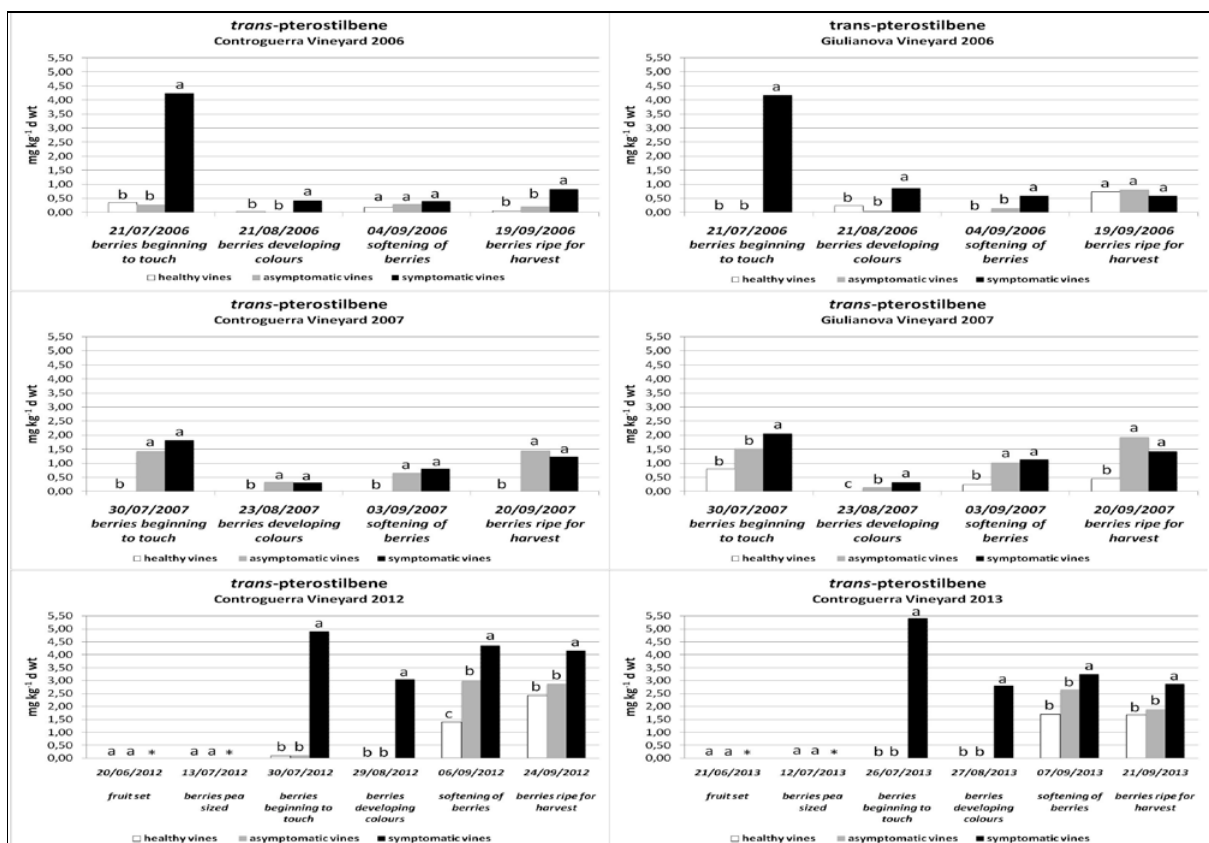
Figure 4. Levels of trans -pterostilbene in the leaves of vines affected with GLSD and in leaves of healthy vines at various growth stages in the 2006, 2007, 2012 and 2013 growing seasons in the Controguerra and Giulianova vineyards. Statistical analysis was performed according to Tukey’s honest significant difference (HSD) test. Each grapevine category (symptomatic, asymptomatic and healthy) comprised 6 replications of leaf data (1 replication = 1 vine) in each growth stage, in each year and in each vineyard. Different letters represent significant differences at P = 0.05. * = no symptomatic vines found;